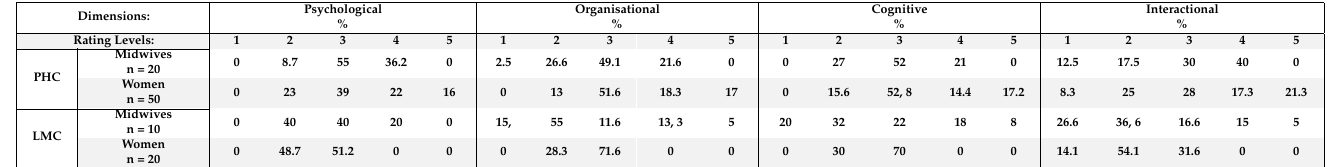
Table 3. Level of satisfaction of midwives and women with respect to NTS mastered and mobilised during